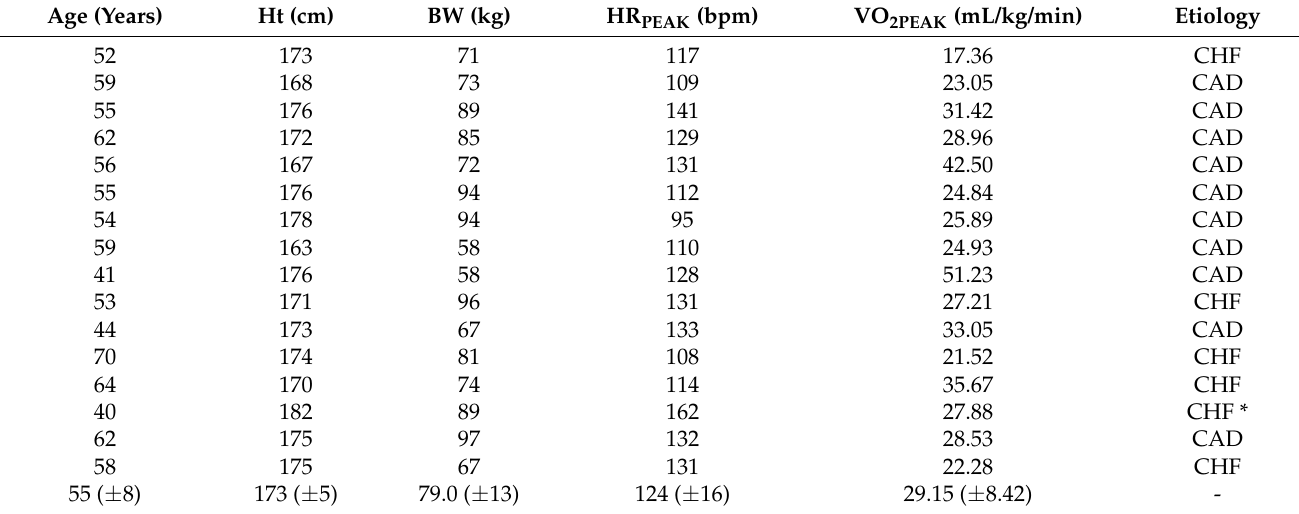
Table 1. Demographic data of all participants ( n =